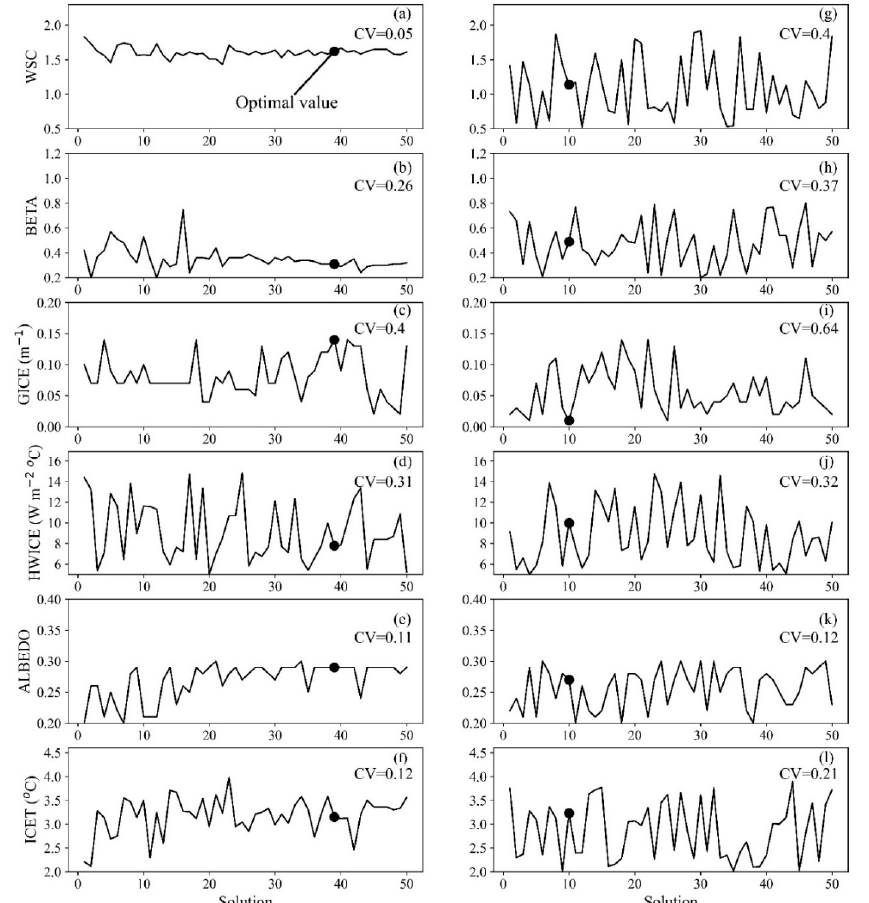
Figure 5. ( a ) IGHS solutions and ( b ) PSO solutions generated through 50 iterations for calibration of CE-QUAL-W2 model. Black open and filled dots represent the local and global optimum solutions. The run-time values of the CE-QUAL-W2 parameters and their optimal values con- tained in IGHS and PSO solutions are presented in Figure 6, which shows that the param- eter values generated by both IGHS and PSO were within their specified ranges (Table 1). Overall, there is a greater variation (CV) in the parameter values among PSO solutions than those among IGHS solutions, which in turn leads to the larger variation in RMSE values observed for PSO algorithm (Figure 5). Examining the variations of the six param- eters during the IGHS calibration indicated that the calibration was mainly driven by the convergence of WSC and BETA (Figure 6a,b).